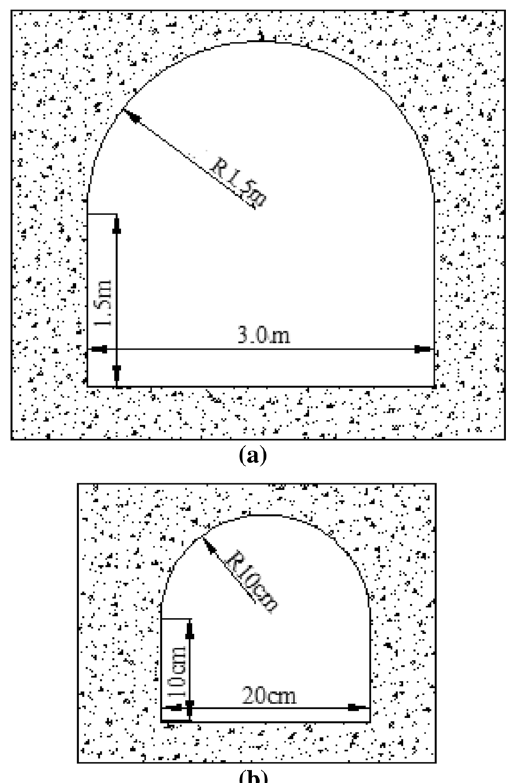
Fig. 2 Cross sections of the a archetypal tunnel and b model